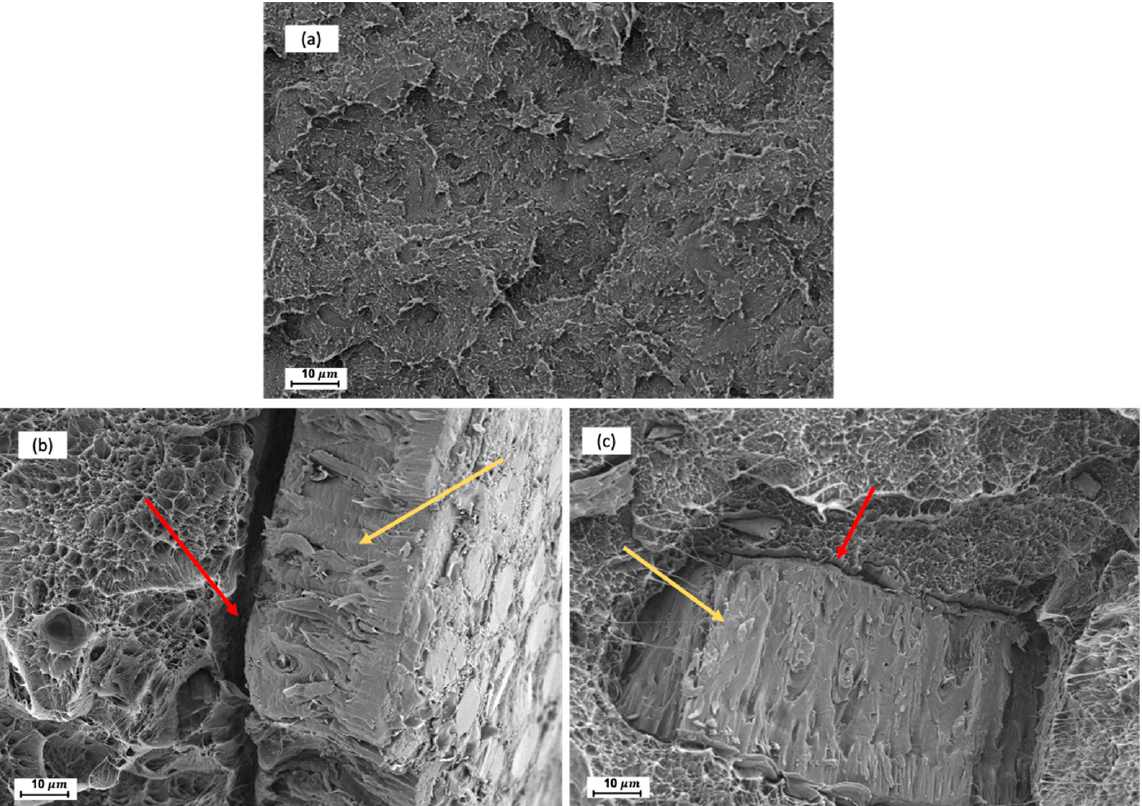
Figure 1. Fracture surface morphology of Charpy test by FESEM at 1000x: ( a ) Bio-based high-density polyethylene; ( b ) 20 wt.% untreated chia seed flour; ( c ) 20 wt.% treated chia seed flour.